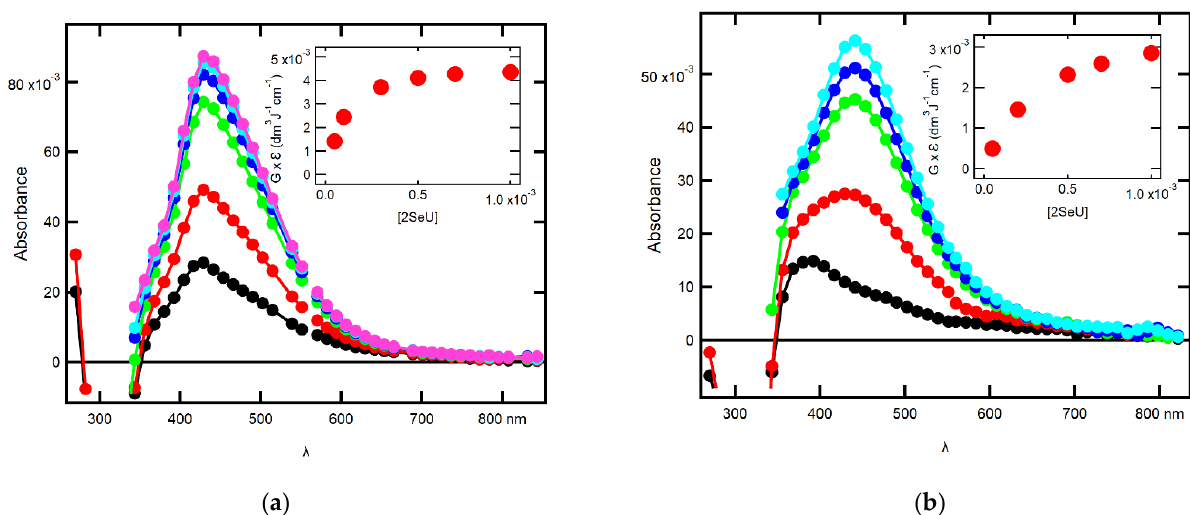
Figure 1. Transient absorption spectra recorded in N 2 O-saturated unbuffered aqueous solutions: ( a ) at pH 4 containing 0.05 mM ( ), 0.1 mM ( ), 0.3 mM ( ), 0.5 mM ( ), 0.7 mM ( ), 1 mM ( ) of 2- SeU recorded 7.8 μ s, 5.4 μ s, 2.5 μ s, 1.6 μ s, 1.2 μ s, and 1 μ s, respectively, after electron pulse; ( b ) at